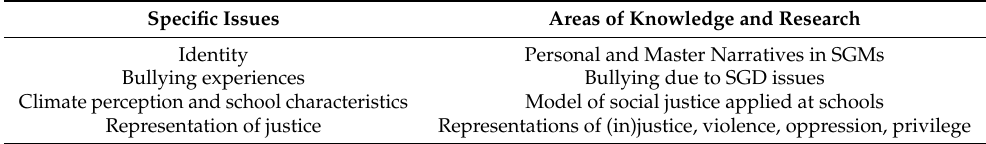
Table 3. List of thematic blocks in the interview and areas of